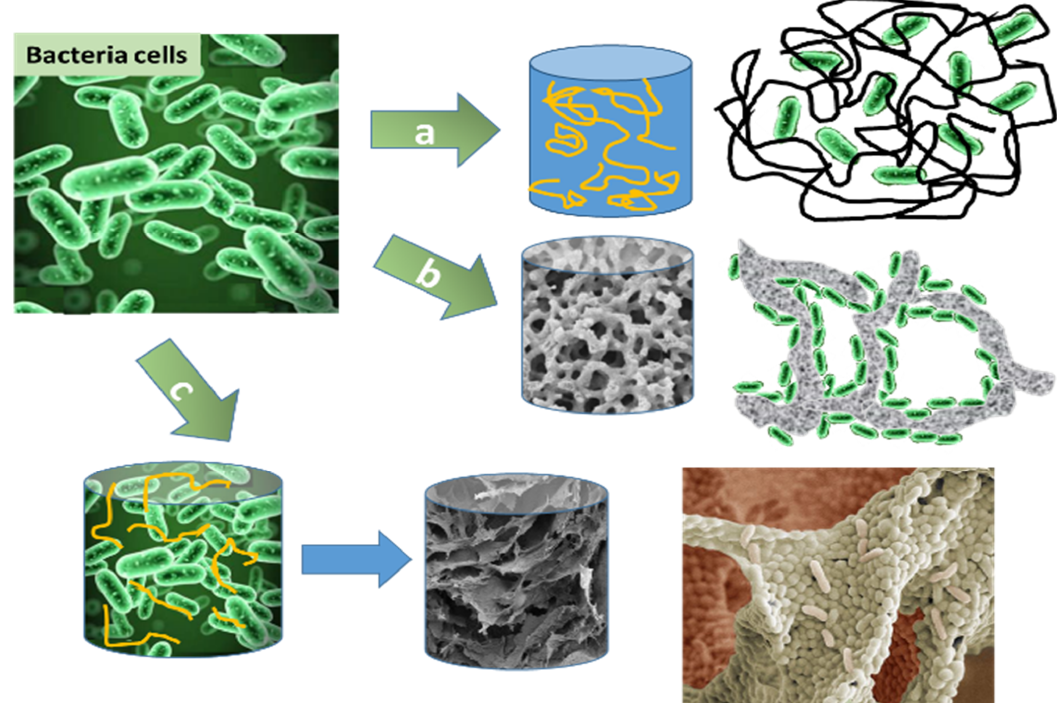
Figure 1. Strategies for bacterial cell immobilisation onto scaffold/polymer supports, and their benefits and limitations: ( a ) physical entrapment of bacteria cells within hydrogel structure; ( b ) biofilm generated on the porous surface of inorganic support; ( c ) macroporous gel formation via direct covalent linkage of bacteria cells at cryostructutation process [23].